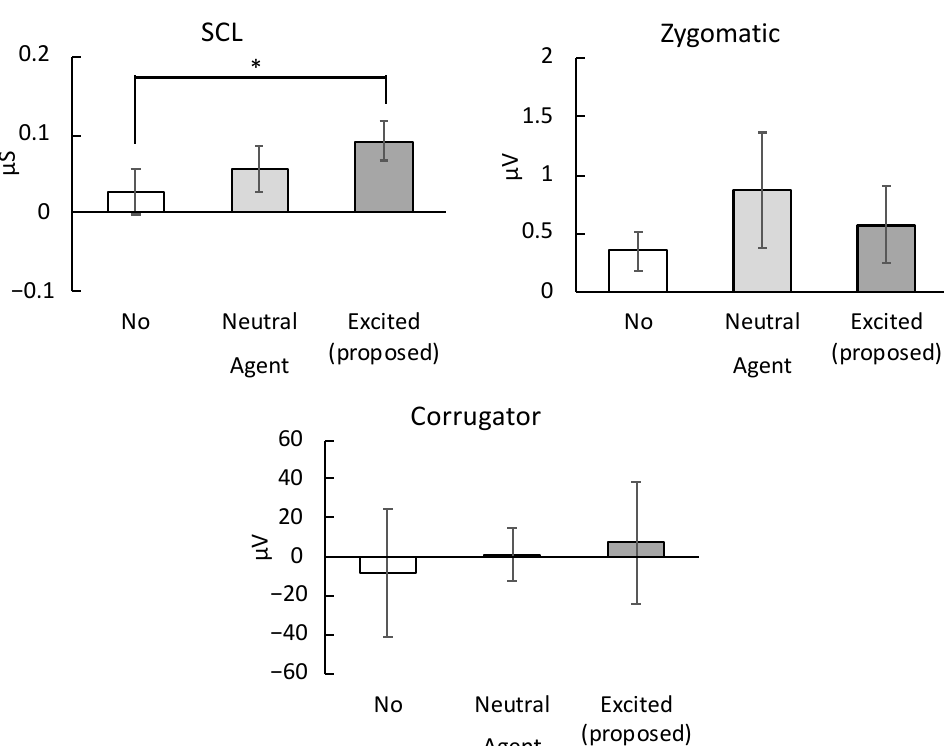
Figure 10. Mean physiological responses (with standard error bars) measured while watching the TV contents: electromyography data of the skin conductance level (SCL) (upper left image), zygomatic major (upper right image), and corrugator supercilii muscle (lower image). * p < 0.05.